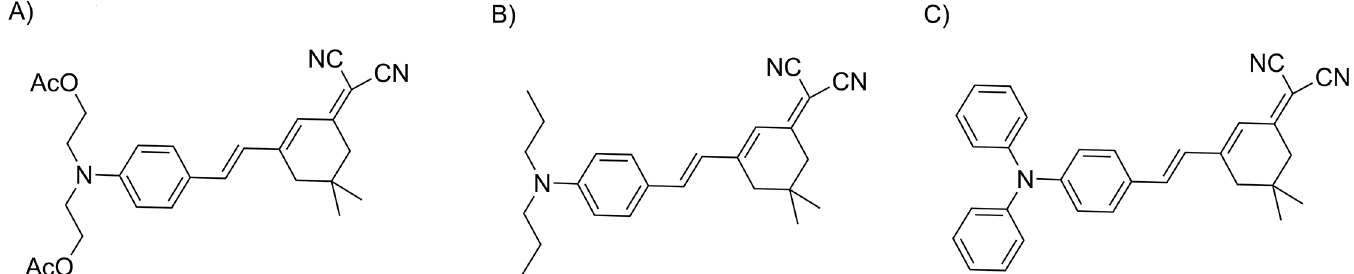
Fig 1. Chemical structures. Structures of: A) Isoa, B) Isob and C) Isoc.